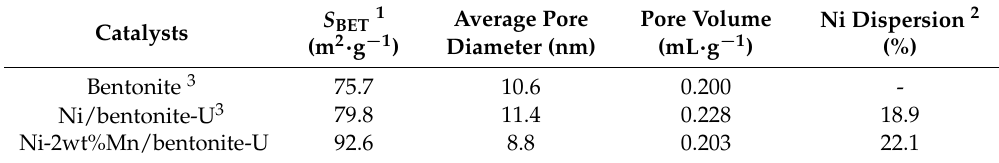
Table 1. Texture properties of the Ni/Bentonite-U and Ni-2wt%Mn/Bentonite-U catalysts.